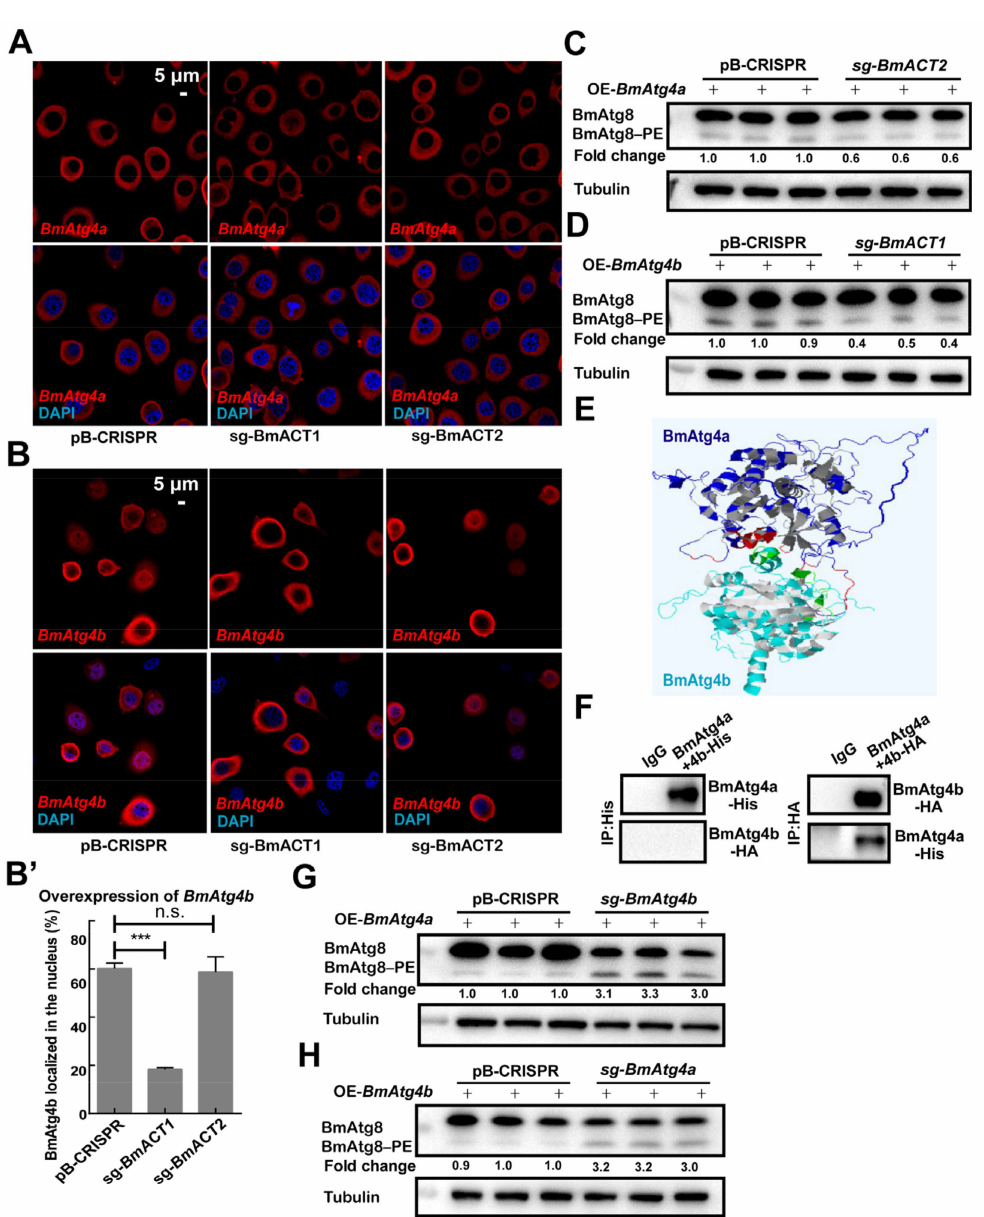
Figure 7. IF staining and autophagic functions of BmAtg4a and BmAtg4b after Knockout of BmACT2 and BmACT1 in BmN cells. ( A ) IF staining of the overexpressed BmAtg4a in the BmACT2 - or BmACT1 - knockout cells. ( B ) IF staining of the overexpressed BmAtg4b in the BmACT2 - or BmACT1 -knockout cells. ( B’ ) Quantification of nuclear BmAtg4b in ( B ) indicated by the percentage of cells stained with BmAtg4b signal in the nuclei. ( C ) Protein levels of BmAtg8/BmAtg8–PE after overexpression of BmAtg4a in the BmACT2 -knockout cells. ( D ) Protein levels of BmAtg8/BmAtg8–PE after over- expression of BmAtg4b in the BmACT1 -knockout cells. ( E ) Predicated binding between BmAtg4a and BmAtg4b based on their putative structures. ( F ) Co-IP assay performed between BmAtg4a and BmAtg4b. ( G ) Protein levels of BmAtg8/BmAtg8–PE after overexpression of BmAtg4a in the BmAtg4b -knockout cells. ( H ) Protein levels of BmAtg8/BmAtg8–PE after overexpression of BmAtg4b in the BmAtg4a -knockout cells. Fold change indicates the variation of BmAtg8–PE protein levels in ( C , D , G , H ). *** p < 0.001, n.s.: no